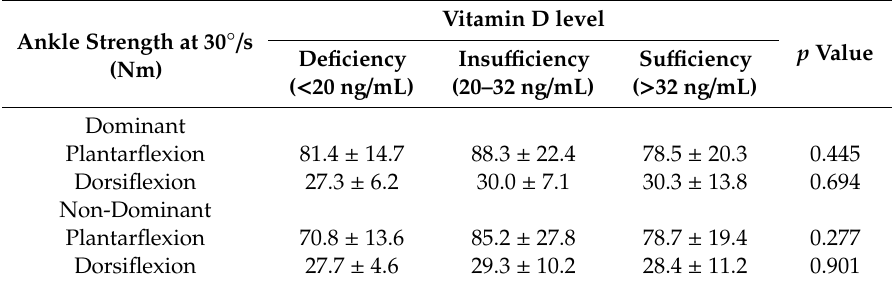
Table 3. Comparison of maximal isokinetic knee strength by vitamin D level. Table 4. Comparison of maximal isokinetic ankle strength by vitamin D level.